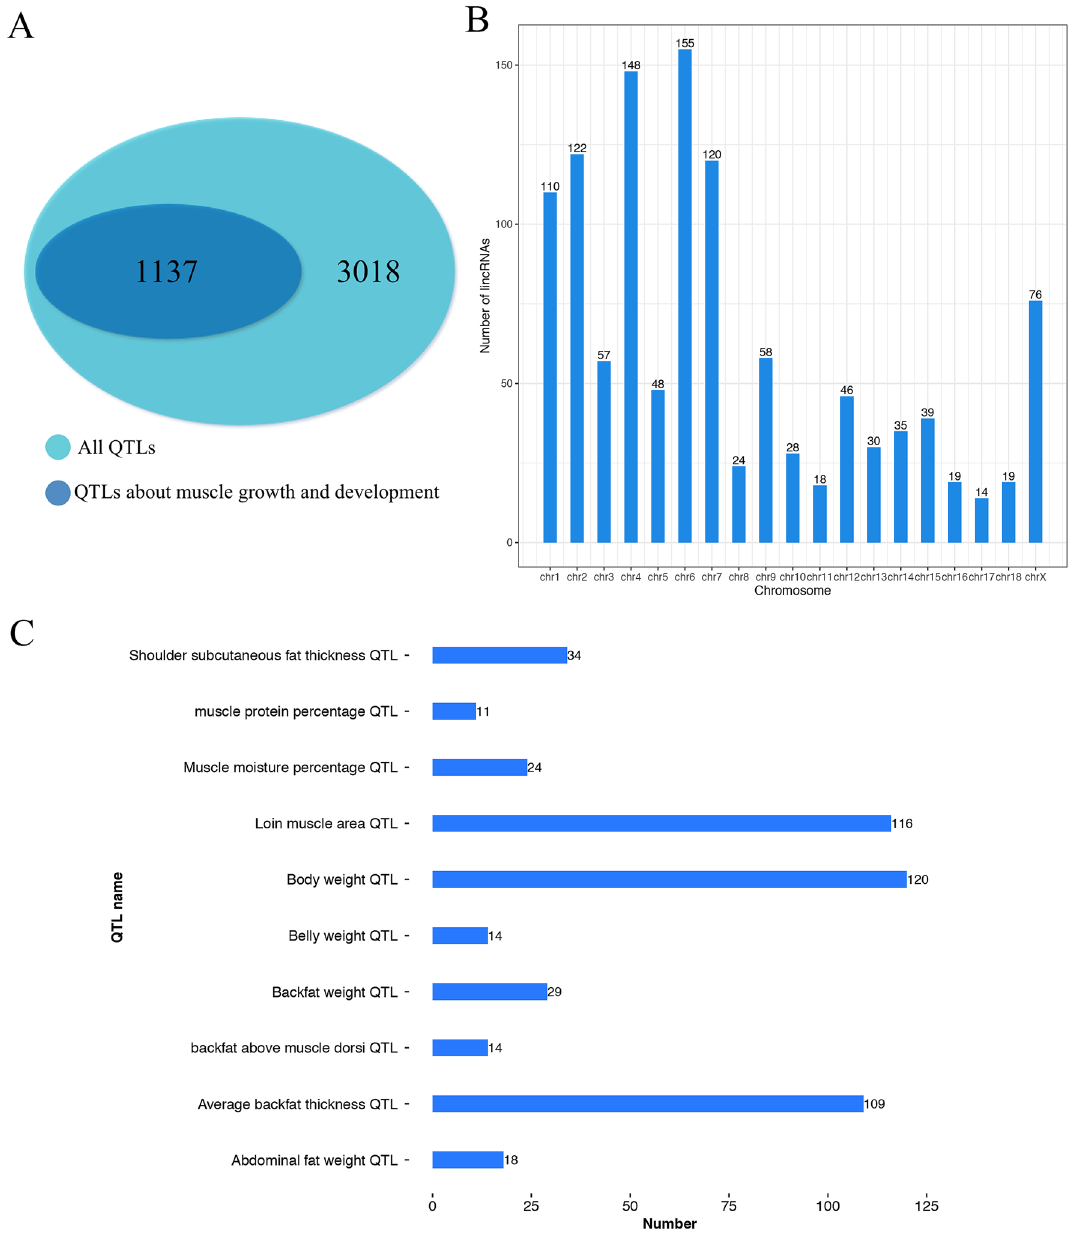
Figure 5. QTL analysis results. ( A ) Percentage of muscle development-related QTLs among all QTLs. ( B ) Distribution of QTL in each chromosome. ( C ) The Top 10 of